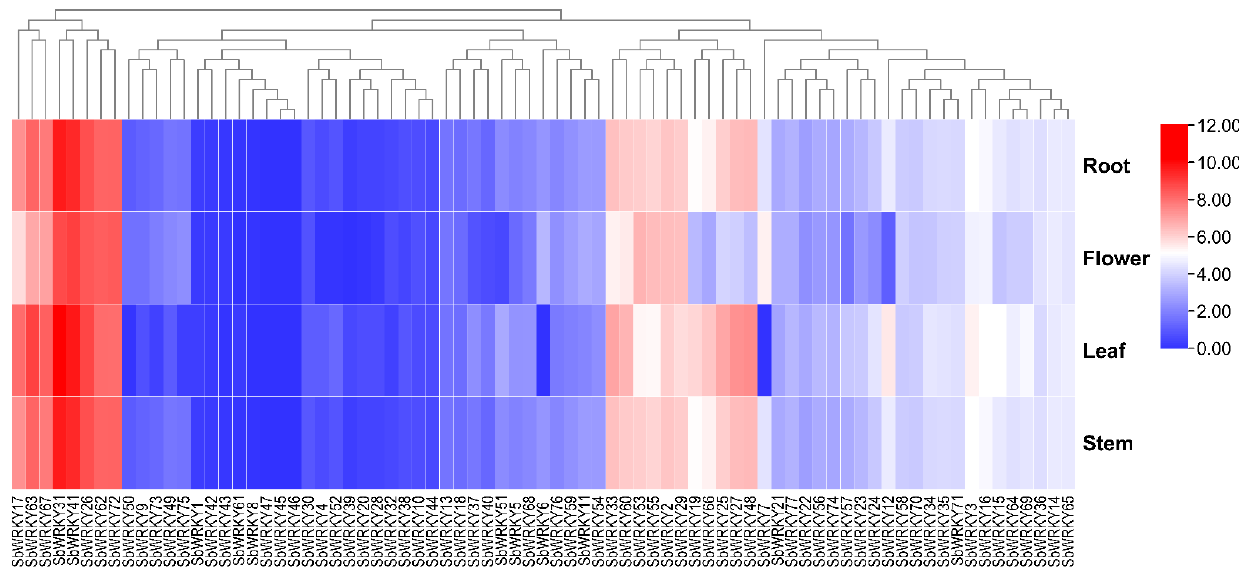
Figure 8. Heat map representation and hierarchical clustering of the SbWRKY gene expression profiles in four tissues. Red and blue boxes indicate high and low expression levels of SbWRKYs , respectively.